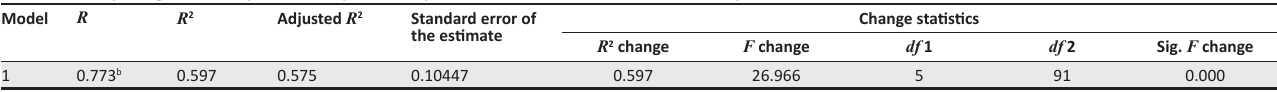
TABLE 5: Multiple regression corporate entrepreneurship and service innovation: model summary. a Model